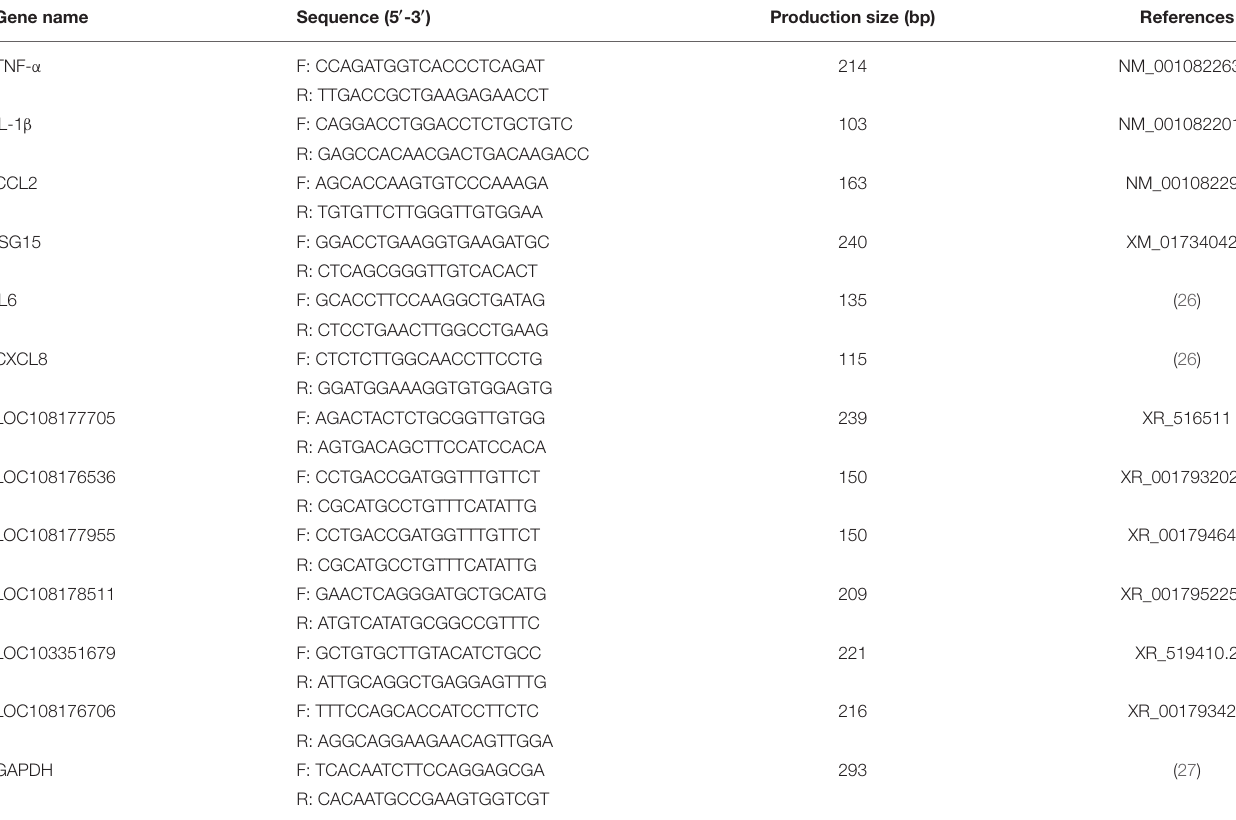
TABLE 1 | The primers used in this experiment for